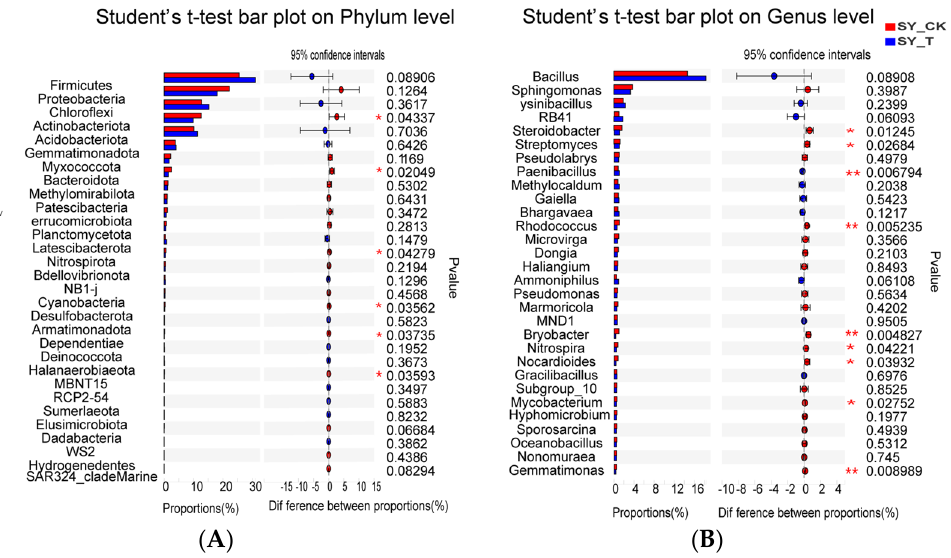
Figure 8. Changes in the relative abundance of bacterial ( A ) phyla and ( B ) genera in triple-fumigated soil that had been used to produce cucumber. ‘Triple fumigation’ refers to the simultaneous appli- cation of chloropicrin, dimethyl disulfide and metham sodium. The t -test reported the statistical differences (asterisked, * 0.01 < p ≤ 0.05; ** 0.001 < p ≤ 0.01) between the means of three replicates within the phylum or genus levels.